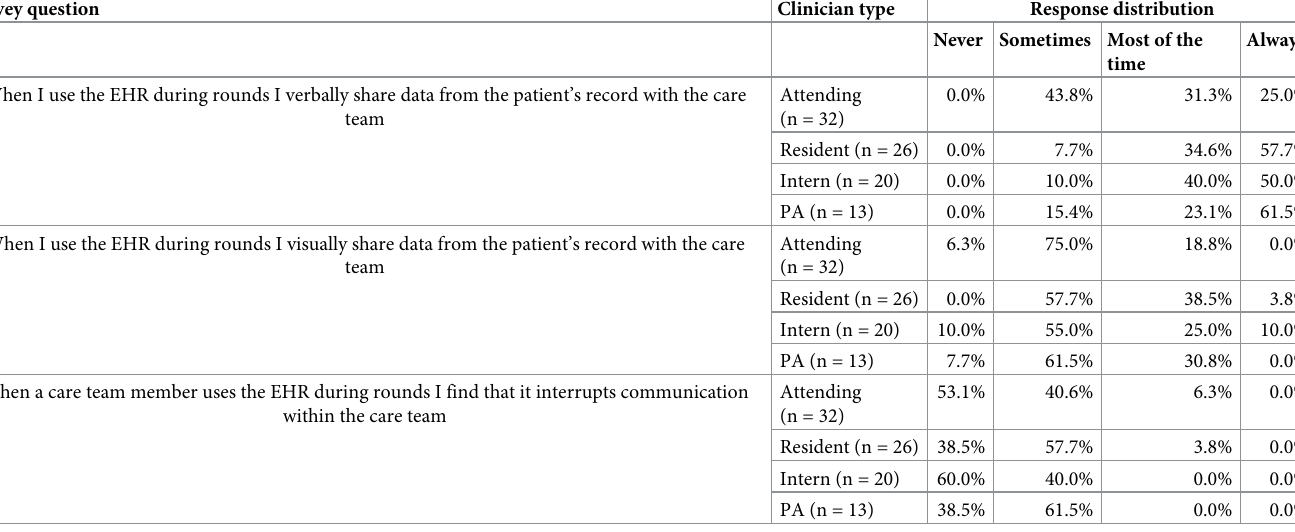
Table 3. EHR use for information sharing and its effect on intra care team communication: Survey responses based on clinician type. Survey question Clinician type Response